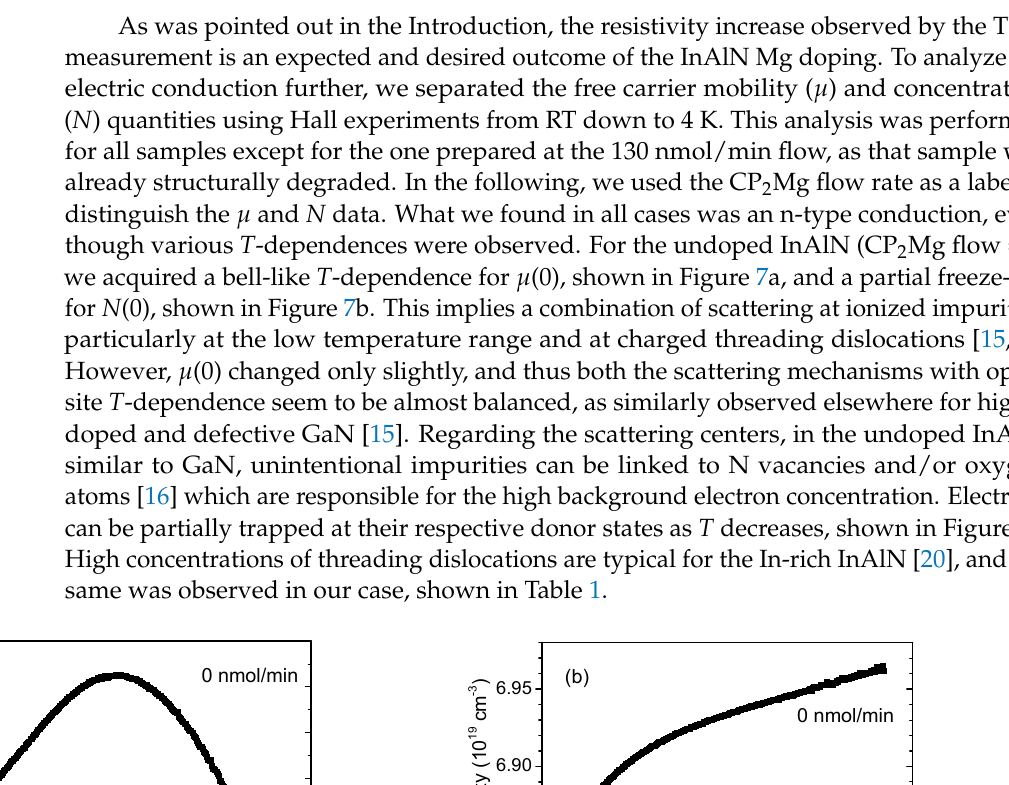
Figure 6. InAlN resistivity TLM method values for different Cp 2 Mg flow.